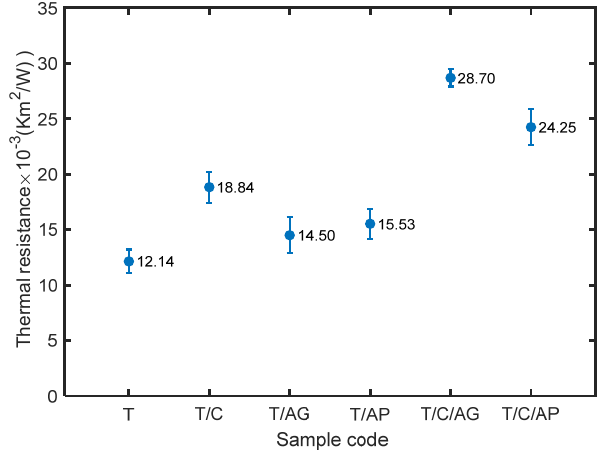
Figure 8. Thermal conductivity of the electro-sprayed materials.